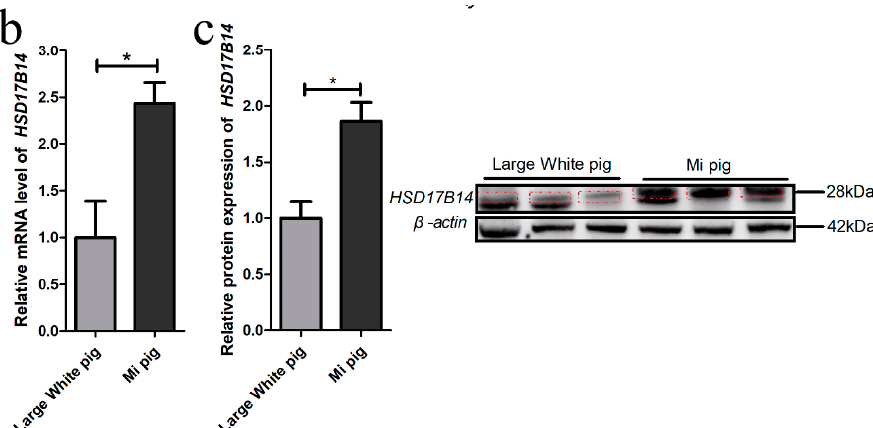
Figure 1. Expression pattern of porcine HSD17B14 gene. ( a ) Expression characteristics of porcine HSD17B14 gene at diestrus and estrus. ( b ) RT-qPCR of Large White and Mi pigs in diestrus. ( c ) Western blot of Large White and Mi pigs in diestrus, the red dotted lines were the purpose strip. Each experiment was repeated three times and the results are represented as means ± S.E.M. * stands for p < 0.05 and *** stands for p < 0.001 ( t -test).